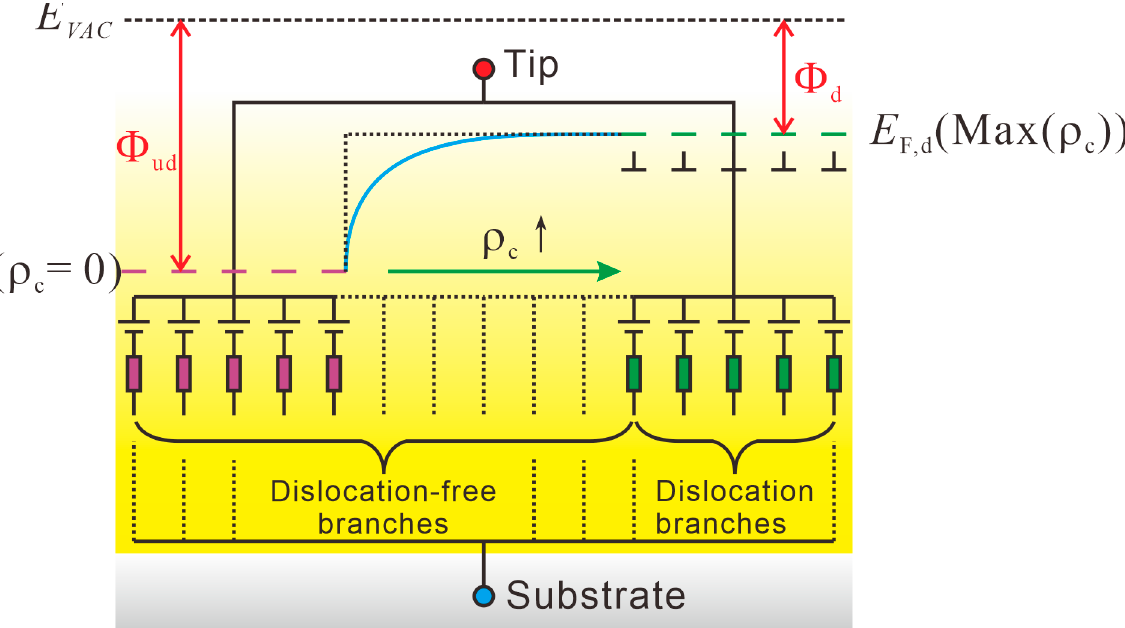
Figure 11. A simplified electrical model for the tip measuring area, U df stands for the voltage difference of dislocation -free branches, U d stands for the voltage difference of dislocation branches. R df stands for the resistance of electrons flowing through the dislocation -free branches, R d stands for the resistance of electrons flowing through the dislocation branches, i stands for the branch current, k stands for the number of dislocation -free branches, N stands for the number of the surface of the grain branches.